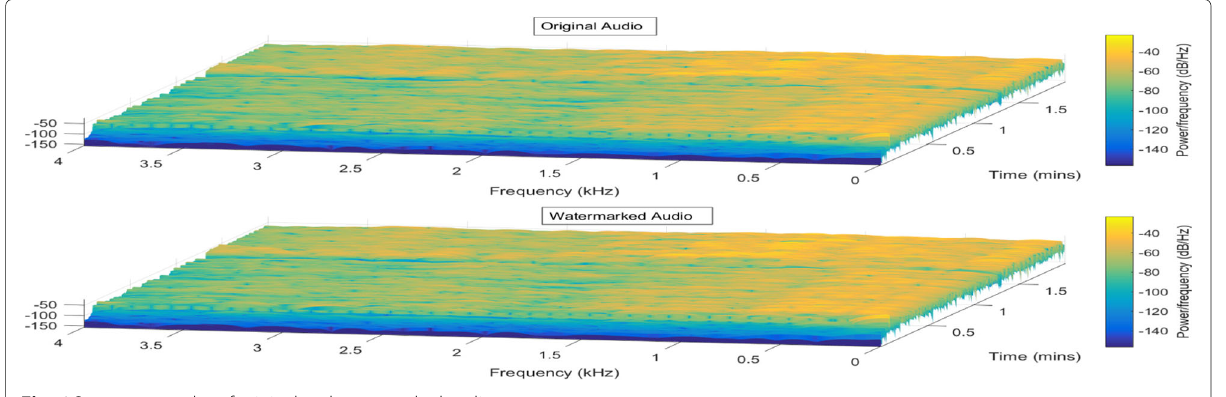
Fig. 6 Spectrogram plot of original and watermarked audio